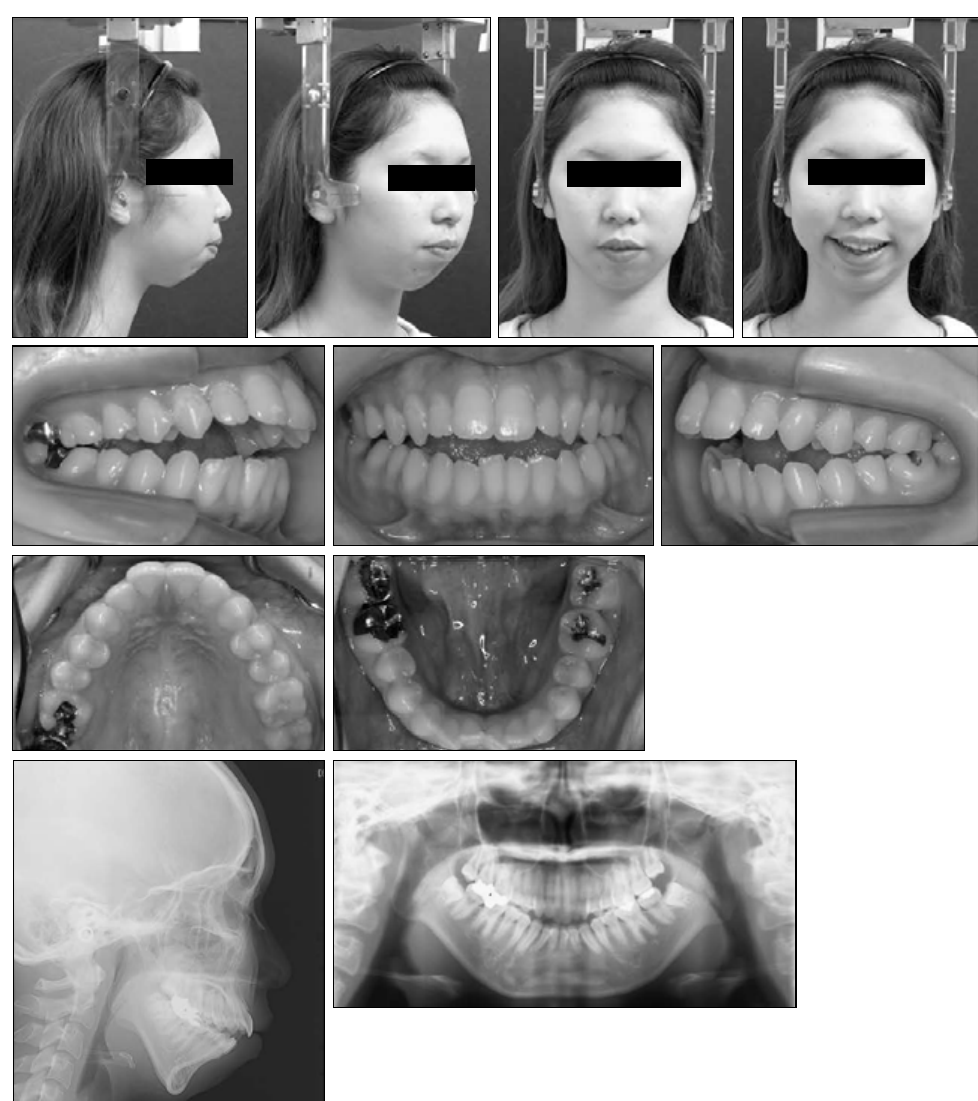
Figure 1. Pretreatment photographs and